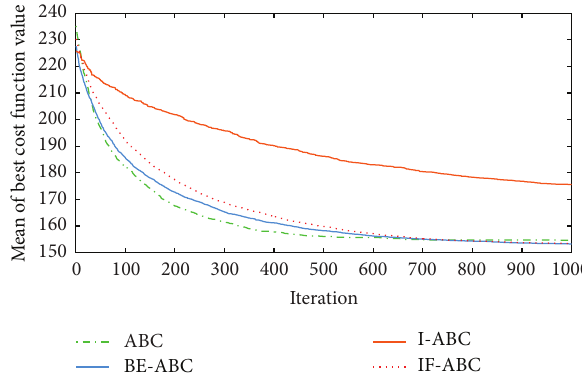
Figure 8: Comparative convergence curves of ABC, I-ABC, IF- ABC, and BE-ABC in Case 2 ( 𝐷 = 30 and MCN = 1000 ).